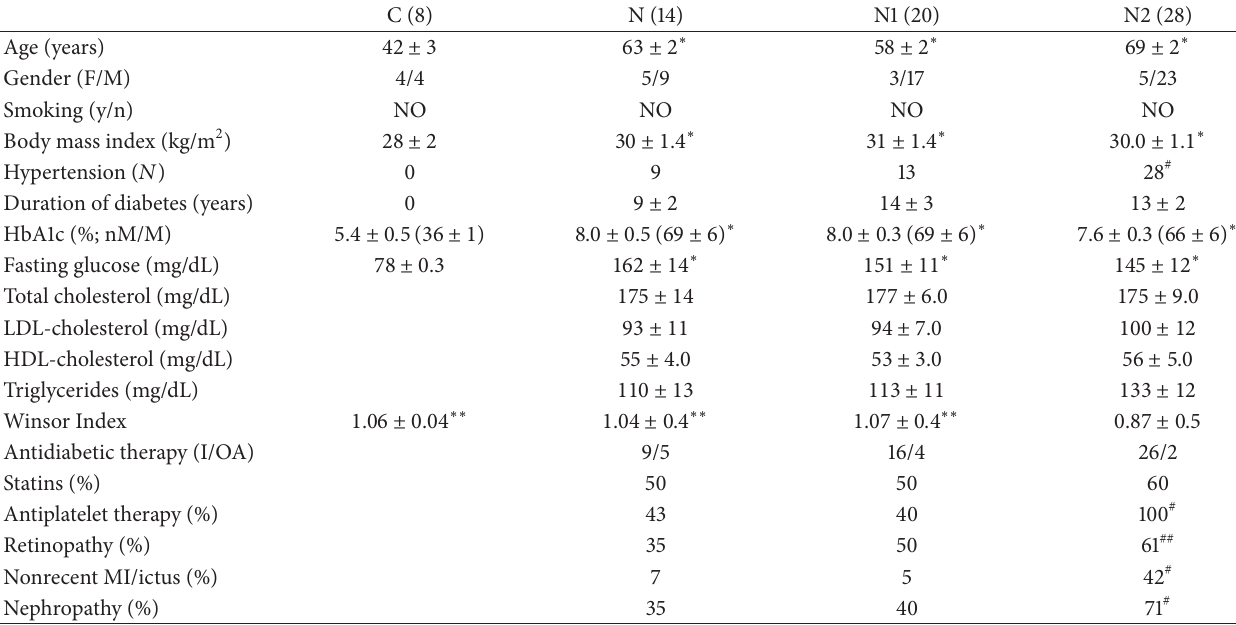
Table 1: Clinical characteristics. 62 diabetic patients divided into 3 groups: nonmacrovascular peripheral neuropathic diabetic patients without foot lesions (N); nonmacrovascular neuropathic diabetic patients with foot lesions (N1); macrovascular neuropathic diabetic patients with ulcers/lesions/osteomyelitis of the lower limbs (N2). Eight healthy controls